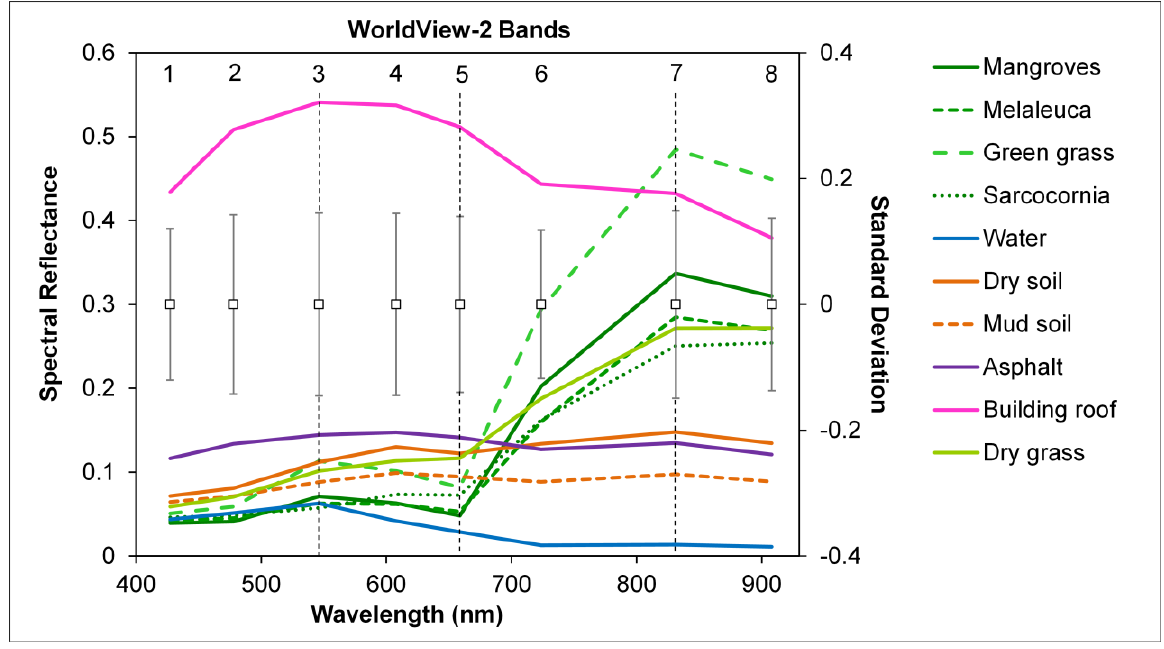
Figure 5. Spectral reflectance profiles of the major land cover types extracted from WV-2 image within the Moreton Bay